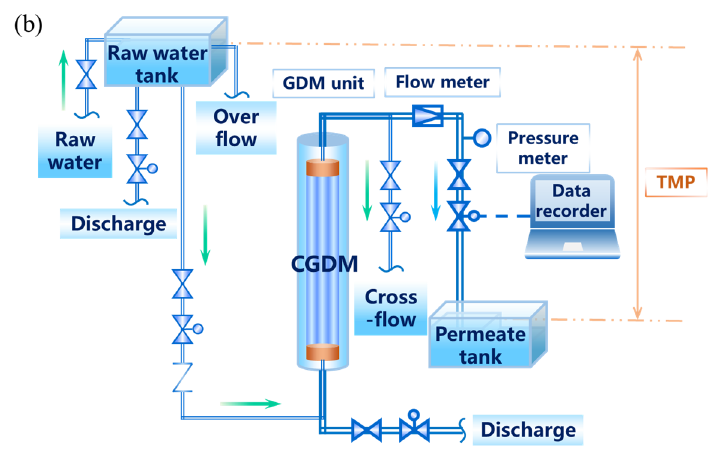
Figure 1. Schematic diagram of the experimental setups: ( a ) SGDM, ( b ) CGDM.